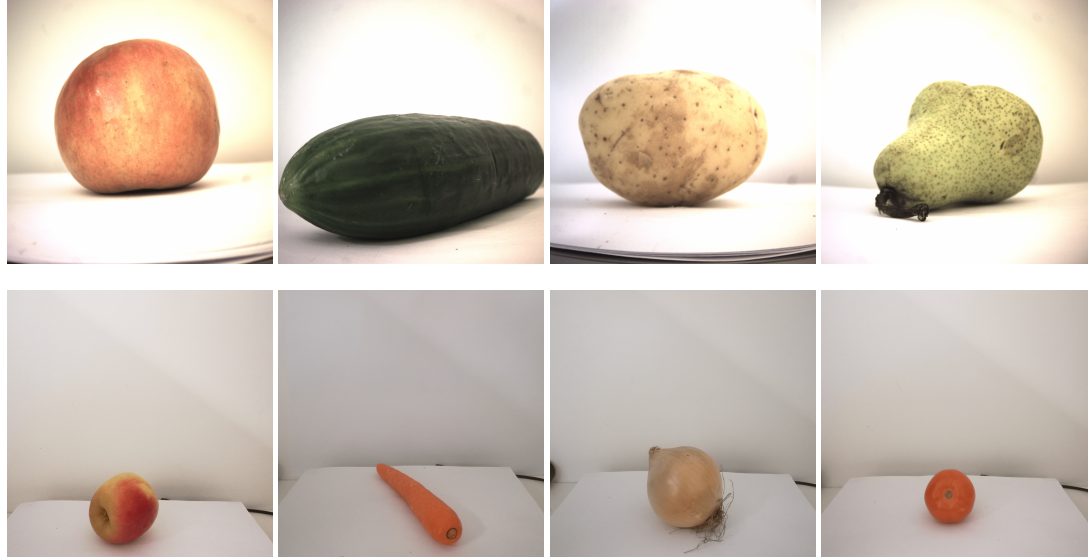
Figure 3. Example images obtained from the experiments with ArduCAM ( upper row ) and Huawei P9 Lite ( bottom row